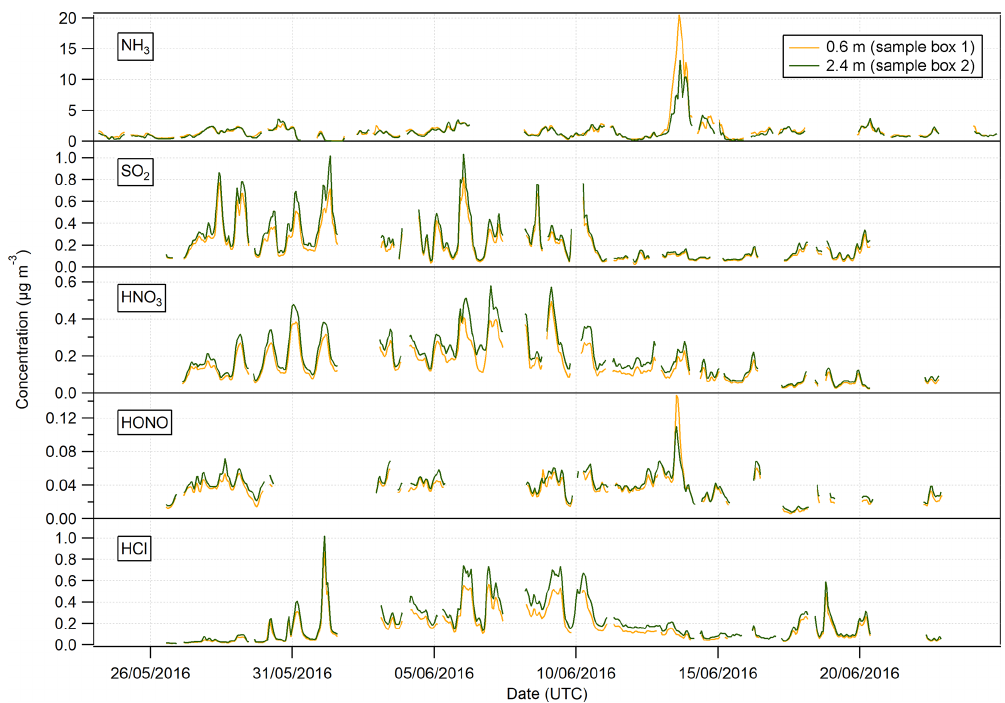
Figure 4. Time series of hourly concentrations of the gaseous species measured during the Easter Bush campaign. Results smoothed using a 5h moving point